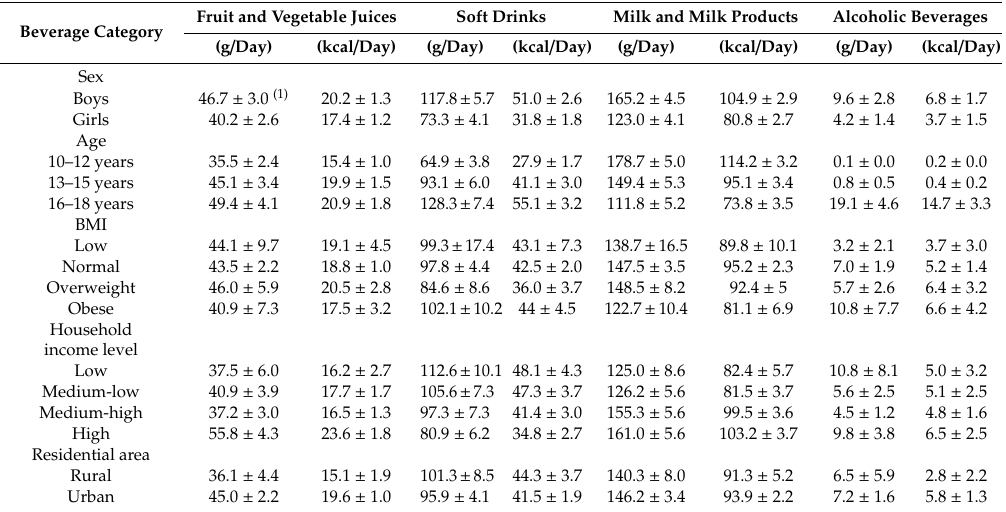
Table 3. Mean ( ± standard error) beverage consumption (in g / day and kcal / day) of the Korean children and adolescents by general characteristic in the KNHANES V, VI and VII